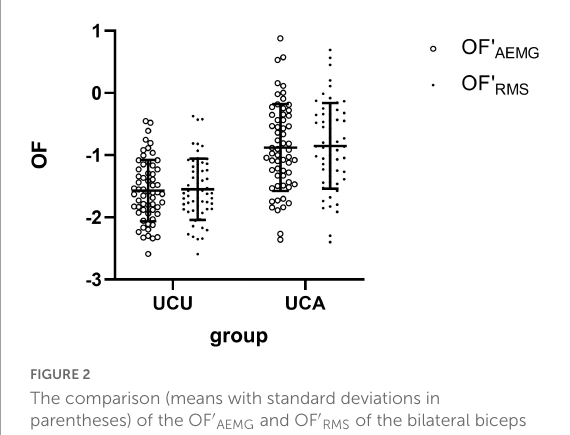
FIGURE2 The comparison (means with standard deviations in parentheses) of the OF (cid:48) AEMG and OF (cid:48) RMS of the bilateral biceps brachii during unilateral contraction tasks. OF (cid:48) AEMG = Log (OF AEMG ), OF (cid:48) RMS = Log (OF RMS ).